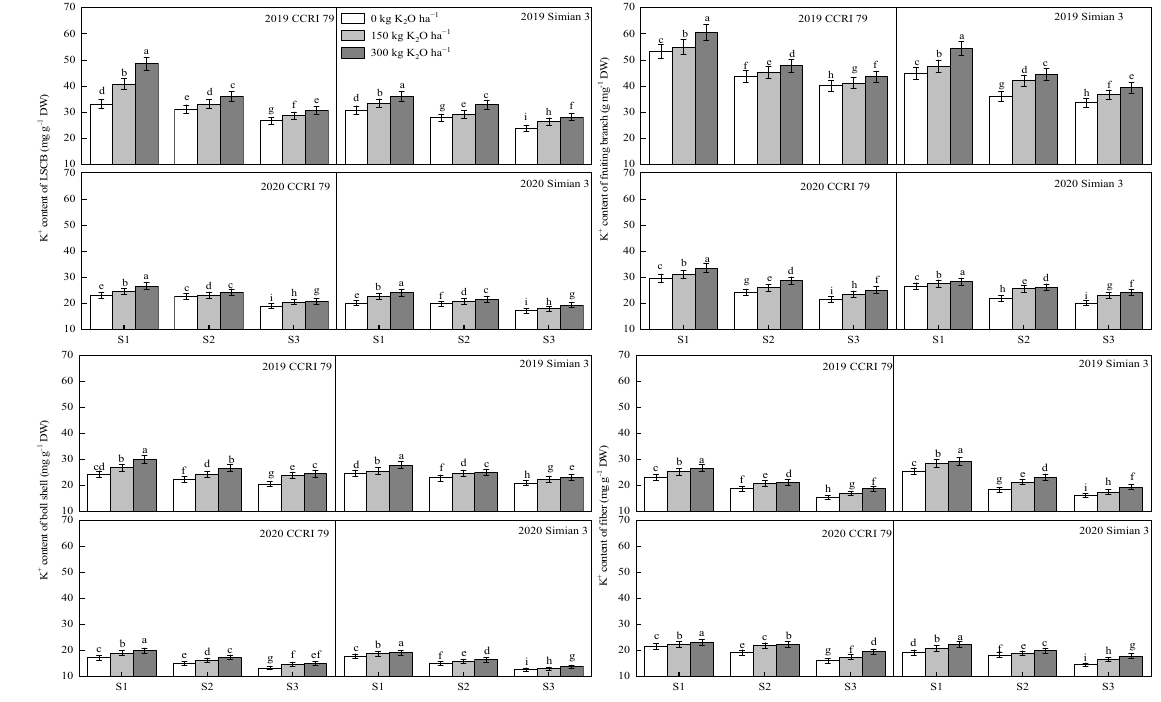
Figure 2. Effect of K application on the content of K + in the boll − leaf system at 15 DPA under salt stress. S1, low salinity; S2, moderate salinity; S3, high salinity. Different letters denote significant differences between the mean values( p < 0.05).